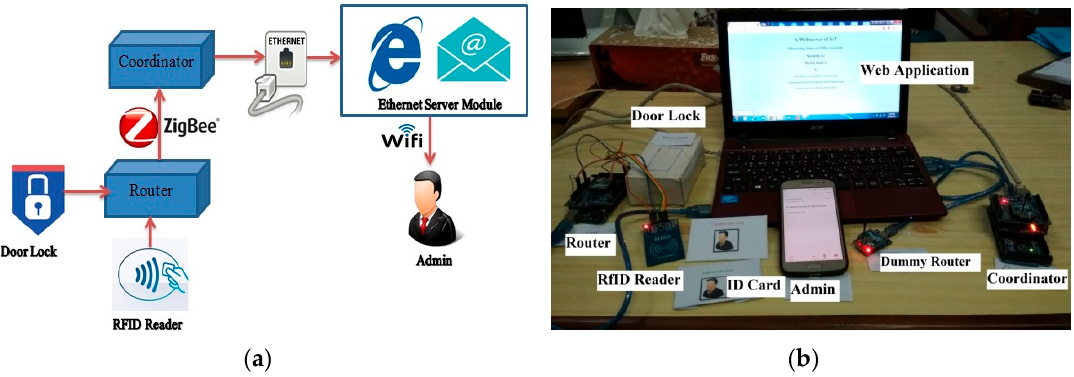
Figure 6. ( a ) Block diagram of the office security system using proposed Security Improvement Framework (SIF); ( b ) photograph of the testbed for implementing the proposed SIF.